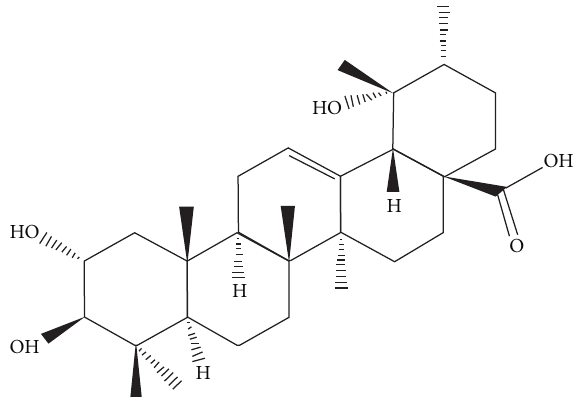
Figure 1: Structural representation of tormentic acid, a compound isolated from C. citrinus